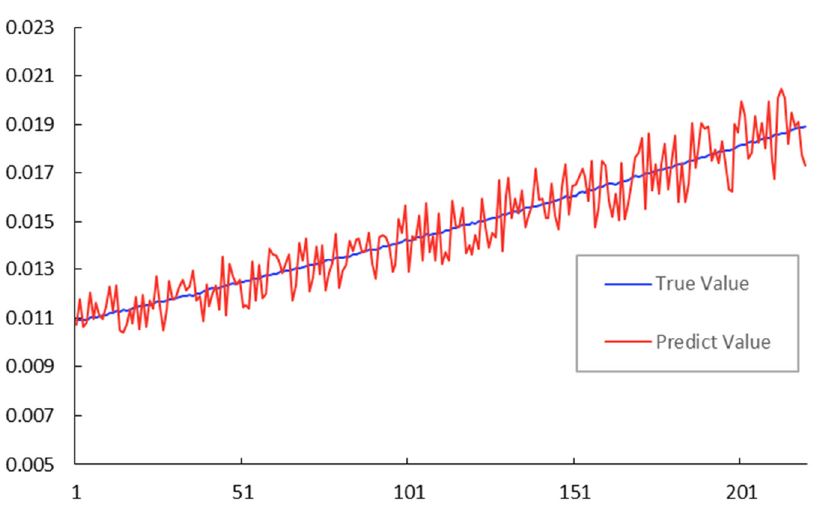
Figure 20. Comparison between prediction RUL and the true RUL of ball screw data.